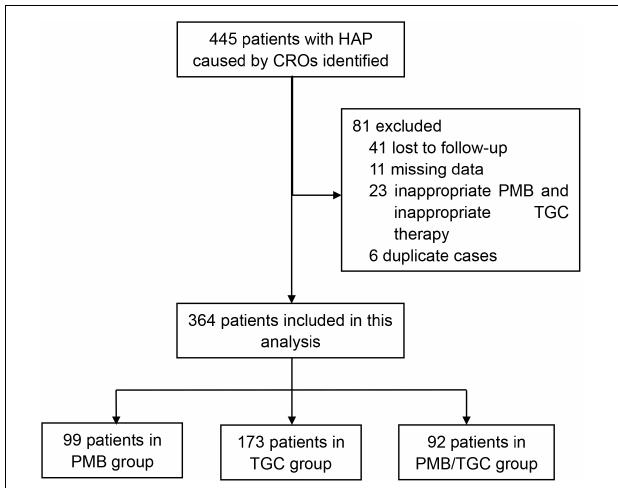
FIGURE 1 | Flow chart for patient enrollment. HAP, hospital-acquired pneumonia; CRO, carbapenem-resistant organisms; PMB, polymyxin B; TGC,